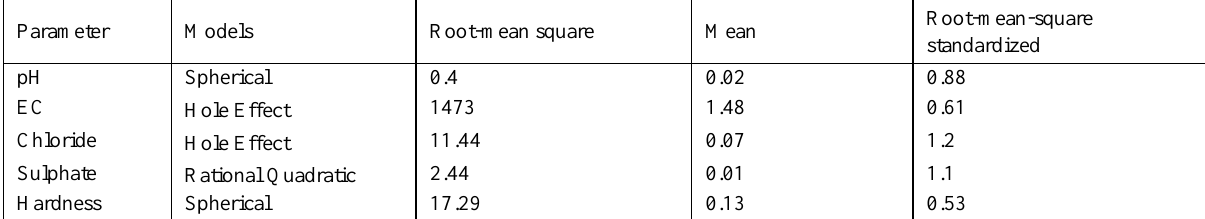
Table 4. Cross-validation results for water quality factors